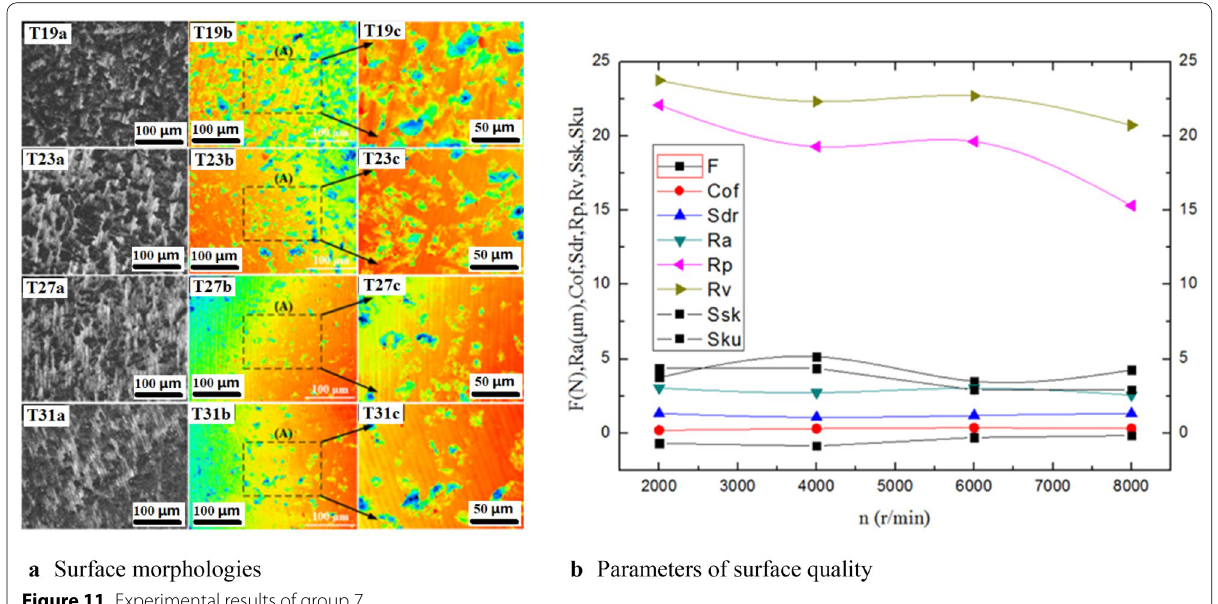
Figure 11 Experimental results of group 7